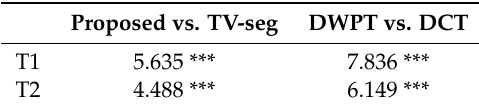
Table 4. The results of pairwise sample t -test for difference